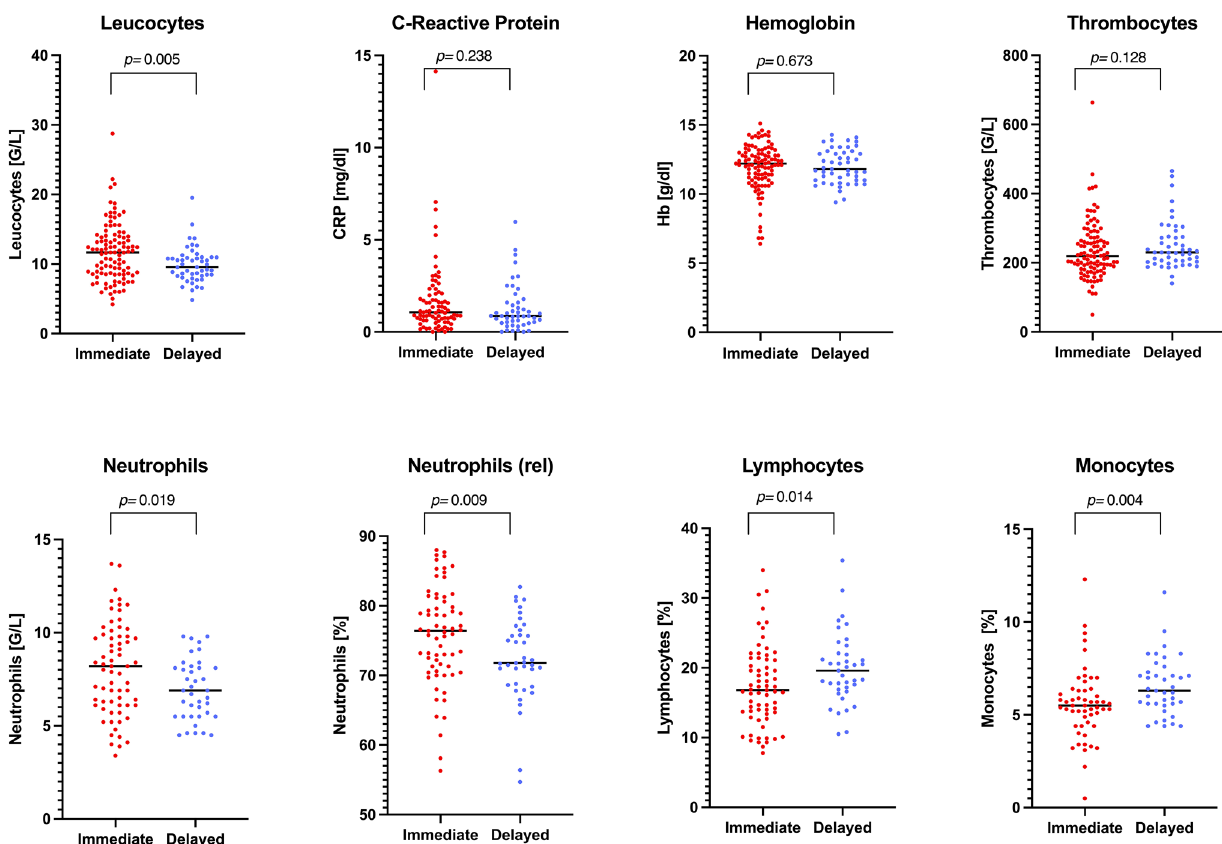
Figure 6. Comparison of maternal laboratory values between immediate versus delayed admission (n = 166, excluding all women who delivered by caesarean section; Scatter dot plot with line at median; Mann–Whitney U test; two-tailed Exact p- value with 99% confidence interval). Figure software: Prism 9 for macOS, Version